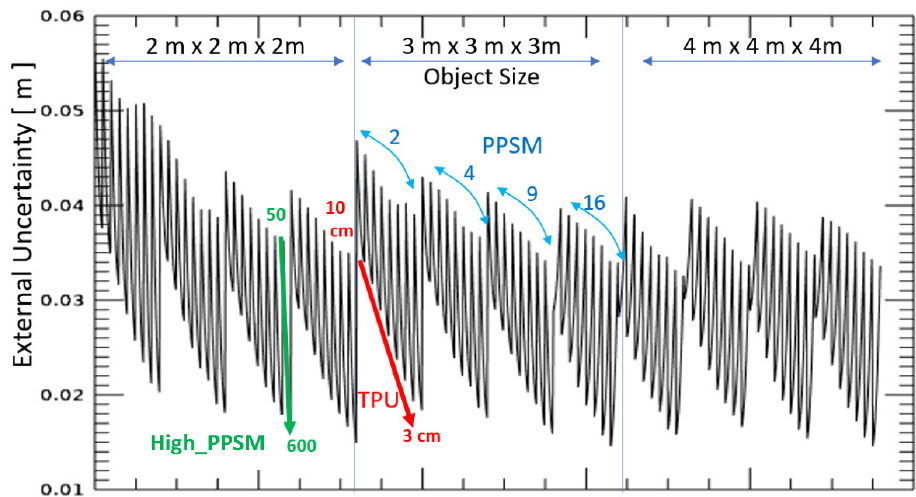
Figure 12. External uncertainty model for amorphous object method on the x-axis.